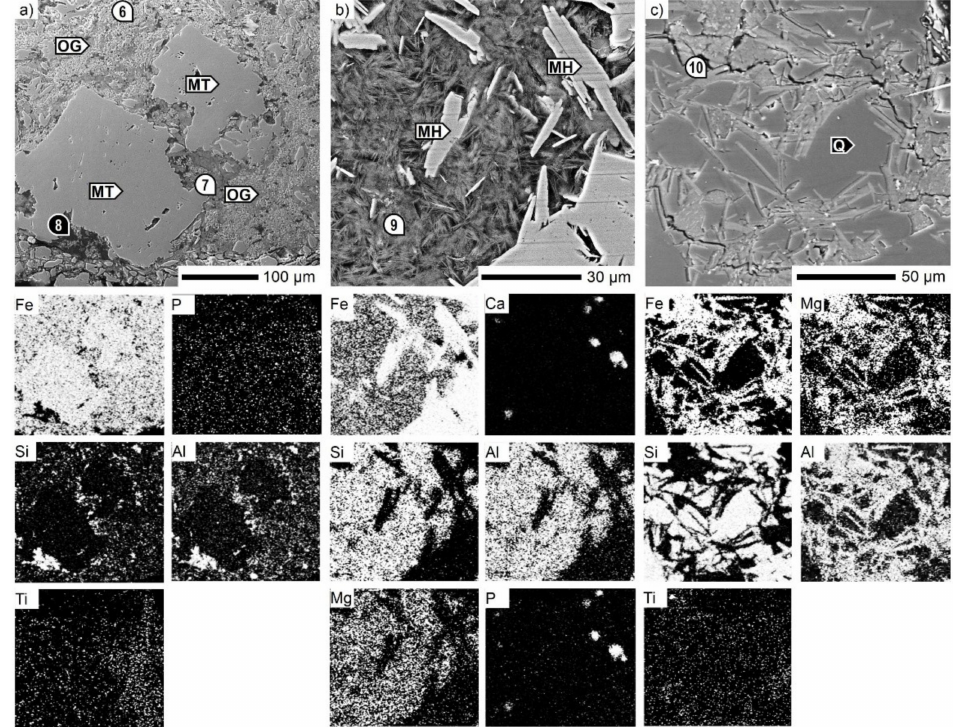
Figure 6. SEM micrographs of the ( a ) Sukha Balka ore ( b ) and ( c ) Zaporozhskiy ore. MH: microplaty hematite, MT: martite, OG: ochreous goethite, Q: quartz, 6–10—see Table